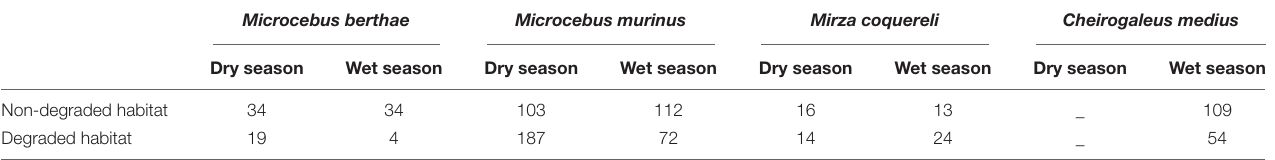
TABLE 2 | (A) Numbers of detected cheirogaleid individuals in the four